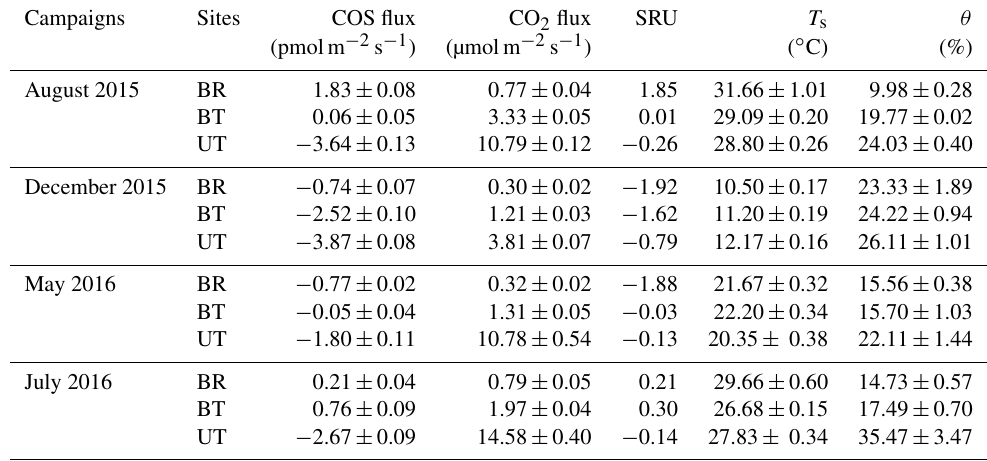
Table 1. Mean values of soil COS and CO 2 flux rates across sites (BR, between rows; BT, between trees; UT, under tree) and seasons, together with the normalized ratio of COS / CO 2 fluxes (SRU), the mean soil temperature at 5cm depth ( T s ) and soil water content (%wt; θ ). Campaigns Sites COS flux